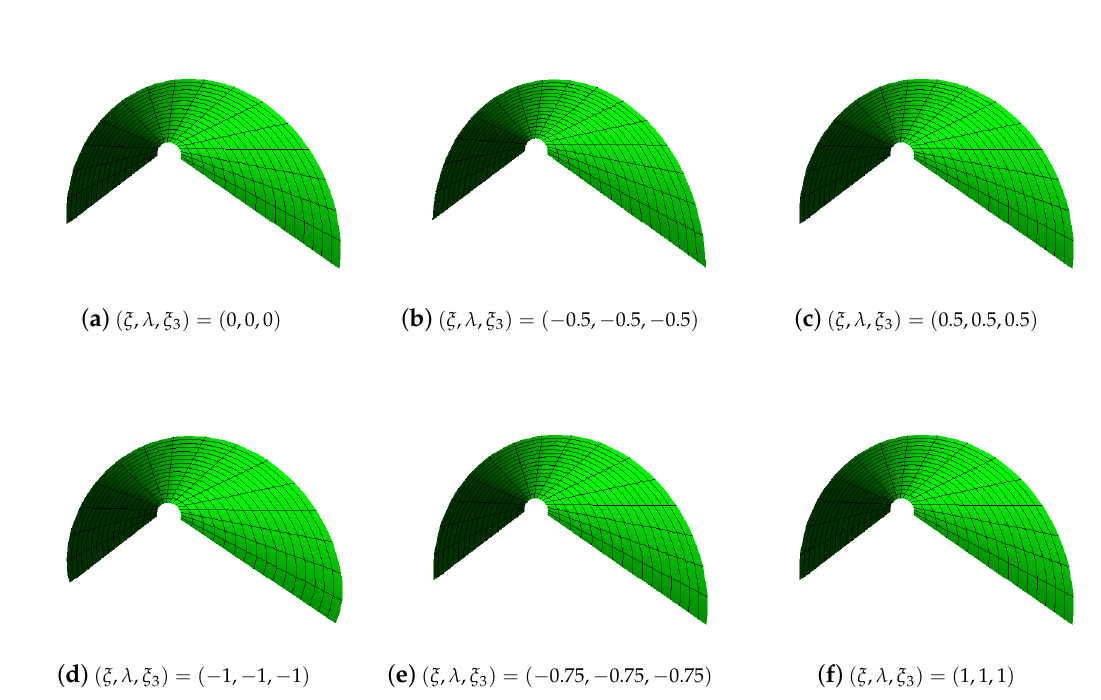
Figure 3. Enveloping developable GHT-Bézier surfaces, having same values of ξ , λ , ξ 3